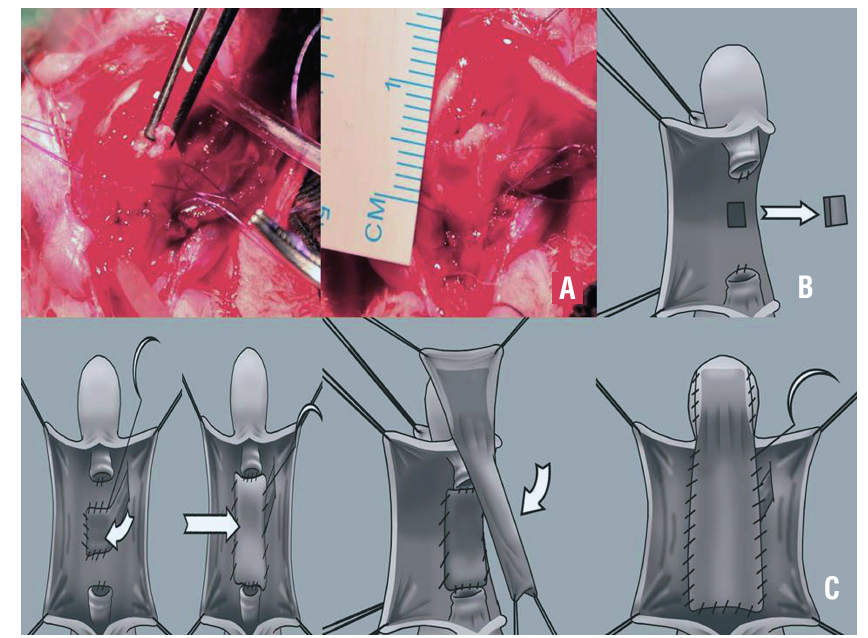
figure 1 - step-by-step description of the technique consisting of a tunica vaginalis flap for reconstruction of the corpora after corporotomy. A buccal mucosa graft was placed directly on top of the flap, and the urethroplasty was completed with an onlay preputial island